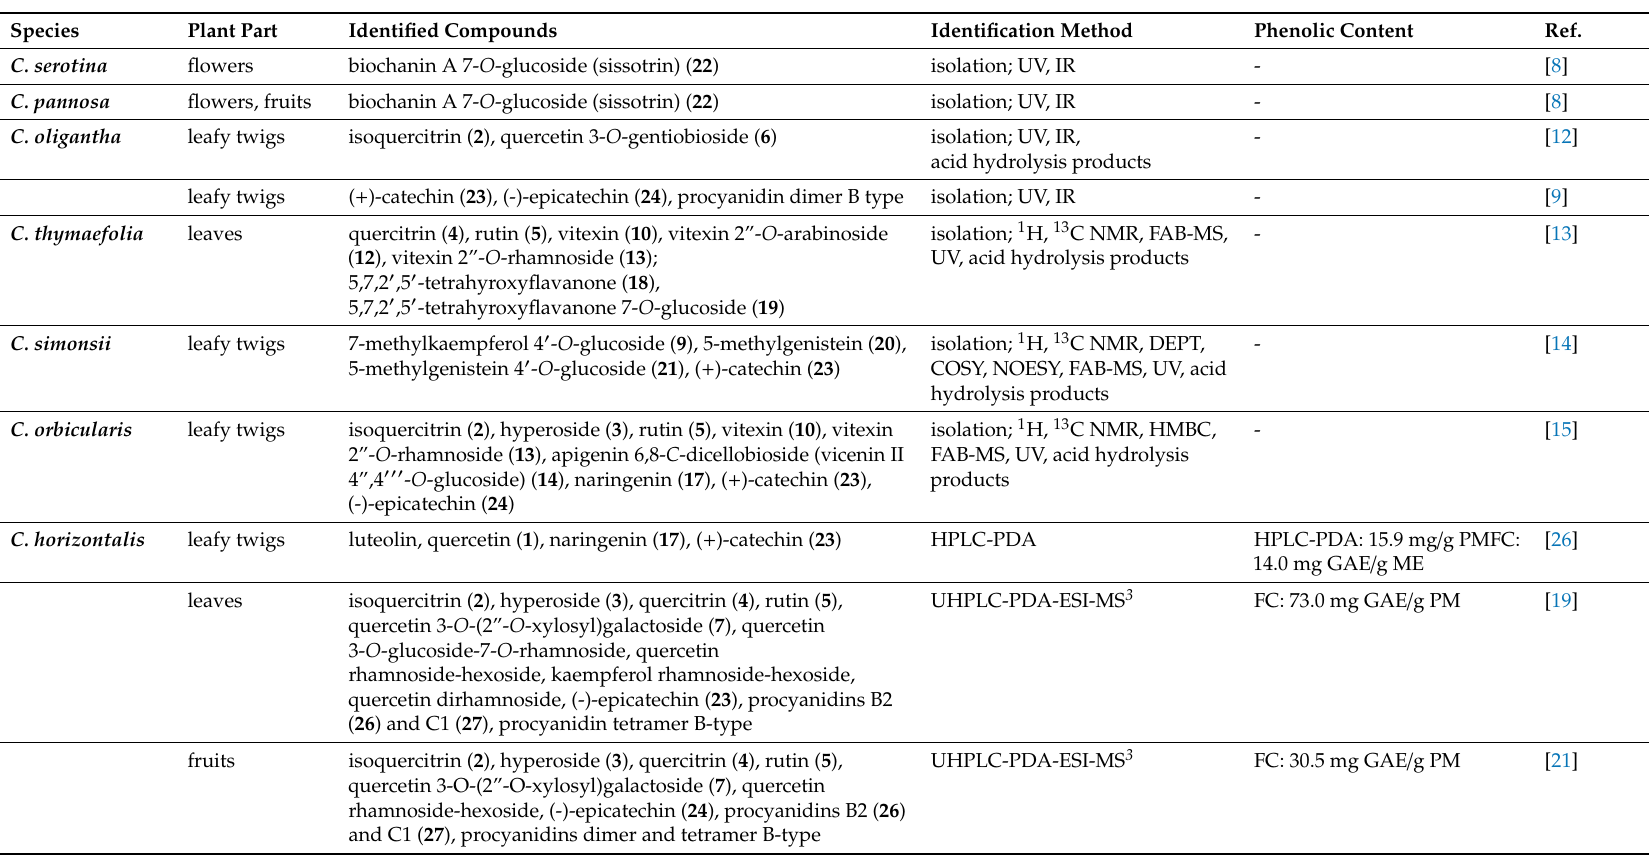
Table 1. Flavonoids and procyanidins found in Cotoneaster species (presented on the basis of original studies published during the revised period 1974–2020; references in chronological